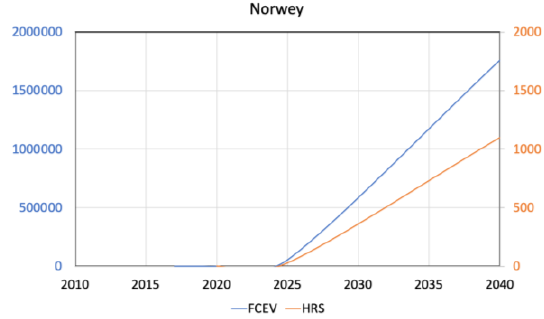
Fig. 6. The number of HRS and FCEVs in Norway